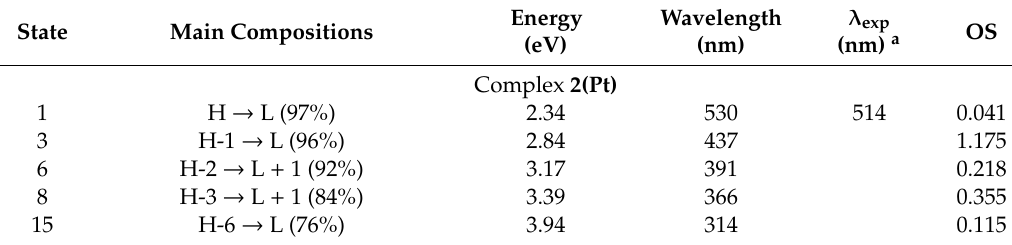
Figure 5. Energy diagrams of the Kohn–Sham orbitals of 2(Pt) and 1(Pt) (B3LYP/LanL2DZ for Pt and 6-31G(d) for other elements) and the shapes of the important orbitals. Table 3. Composition, energy (eV), calculated and experimental absorption wavelengths (nm), and oscillator strength (OS) of the relevant electronic transitions of ligands 1 and 2 and of platinum complexes 2(Pt) and 1(Pt) in CH 2 Cl 2 (only transitions with: OS > 0.01 and composition >10% considered; H = HOMO, L = LUMO). a From Table 2.